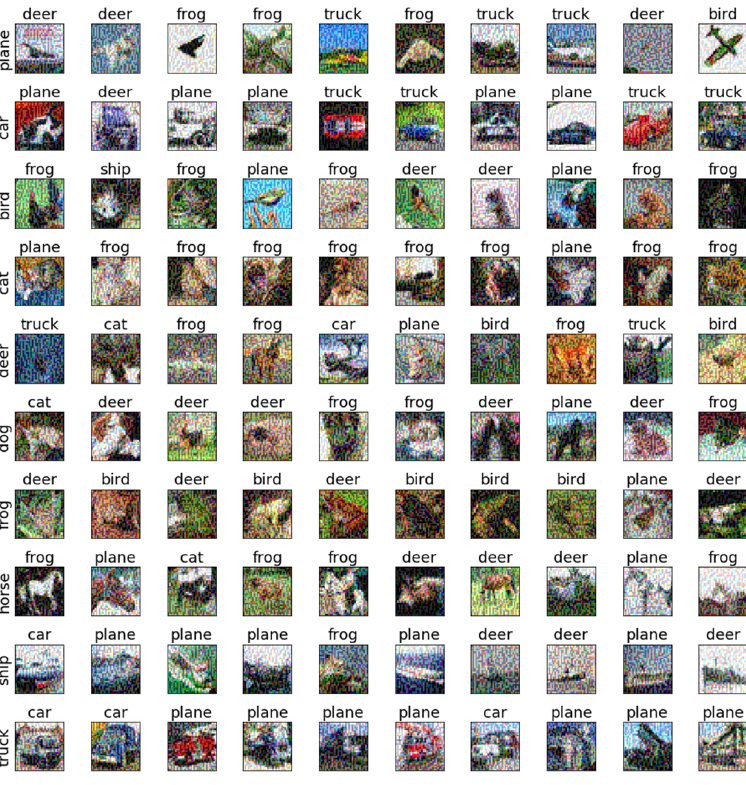
Figure 15. The adversarial examples of CW for Cifar10 and ResNet18.